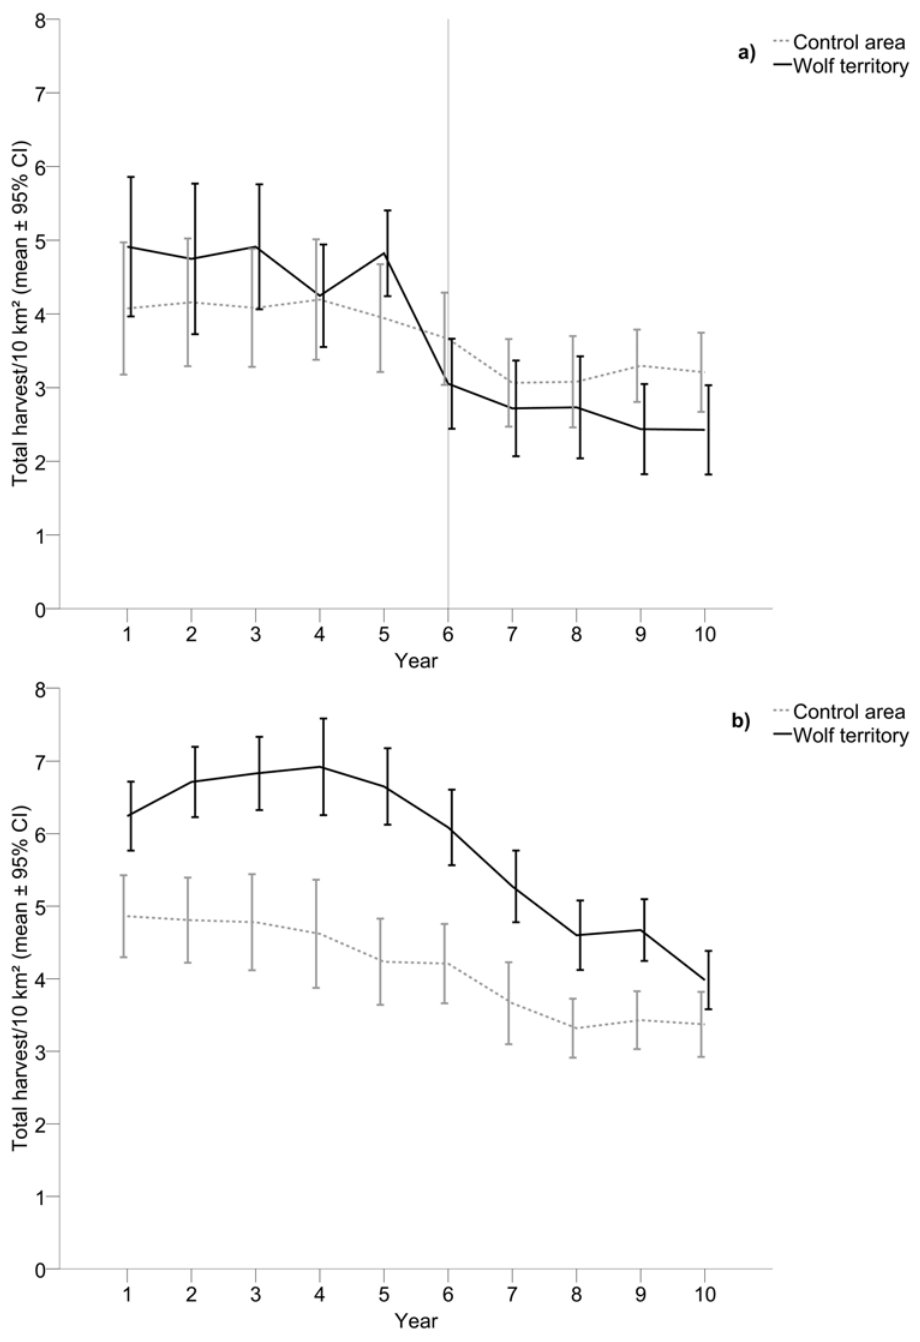
Fig 1. Harvest of moose within wolf territories compared to control areas. Total harvest of moose (males, females and calves pooled) during a) five years prior to wolf establishment and five years with wolf presence (n = 25) compared to control areas, and b) ten years with presence of wolves (n = 43) compared to control areas. The vertical line in a) indicates the first year with wolf presence.